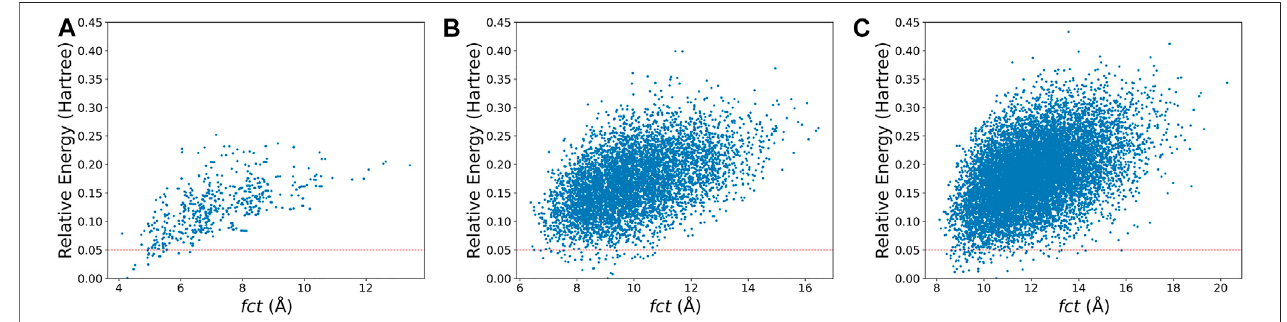
FIGURE5| Therelativeenergy- fct diagramsforthexTB-optimizedstructuresoftherandomlygeneratedpopulationsof (A) P + 9 , (B) P + 19 and (C) P + 31 .Everydotinthe picture corresponds one structure and the dots below the red line indicates the isomers have relative energies less than 0.05 hartree compared to the corresponding global minimum in each subgraph.